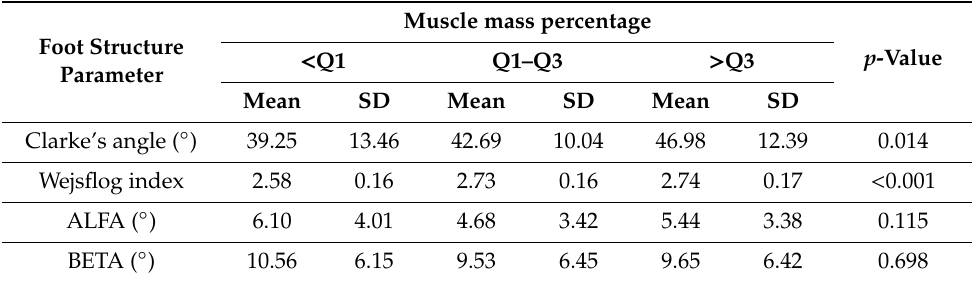
Table 3. Assessment of foot structure indices and muscle mass